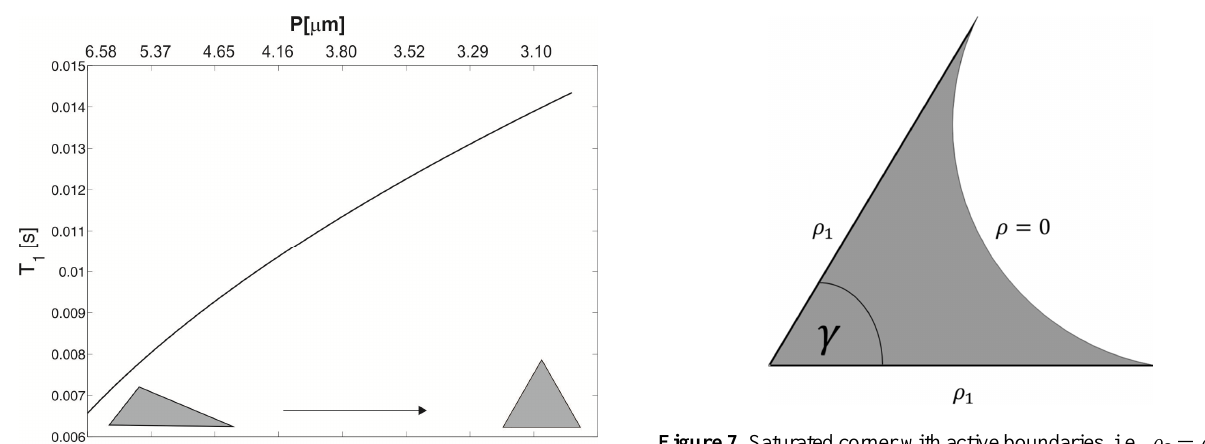
Figure 7. Saturated corner with active boundaries, i.e., ρ s = ρ 1 > 0 at the corner’s perimeter P γ and a passive boundary at the air–water interface (meniscus), i.e., ρ s = ρ = Figure 6. Longitudinal relaxation times T 1 of fully saturated trian- gular pores with constant cross-sectional area A = 4 . 33 × 10 − 13 m 2 versus shape factor G = A and perimeter P . NMR parameters: P 2 ρ s = 10µms − 1 , T 1B = 3.